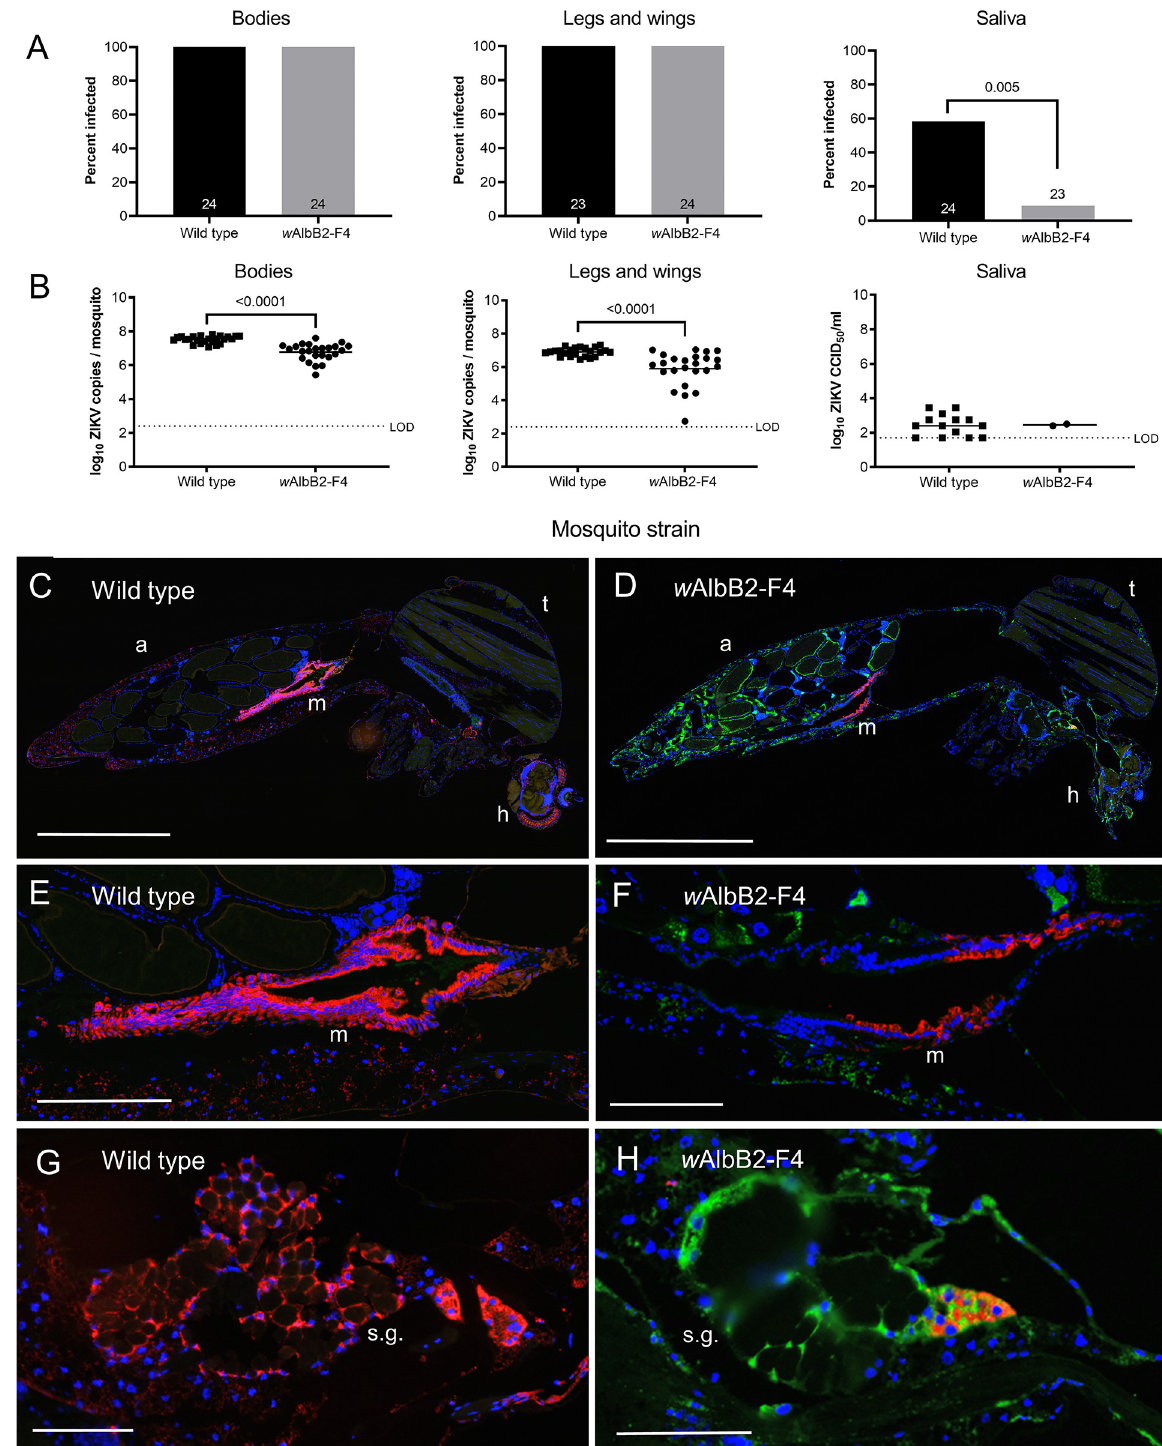
Fig 3. Wolbachia inhibit ZIKV infections in Ae . aegypti w AlbB2-F4 mosquitoes. (A) ZIKV virus infection prevalence in Ae . aegypti wild type and w AlbB2-F4 mosquitoes 14 d after feeding on a blood meal containing 1 × 10 8.5 CCID 50 /ml (in C6/36 cells) of Zika virus. P values are included for comparisons with significant differences in mosquito infection rates between w AlbB2-F4 and wild type mosquitoes (Fisher’s Exact test). (B). ZIKV infection densities in mosquitoes from A. Virus copy numbers were determined from bodies, legs and wings and saliva samples using qRT-PCR. P values are shown for comparisons with significant different median virus copy numbers between w AlbB2-F4 and wild type